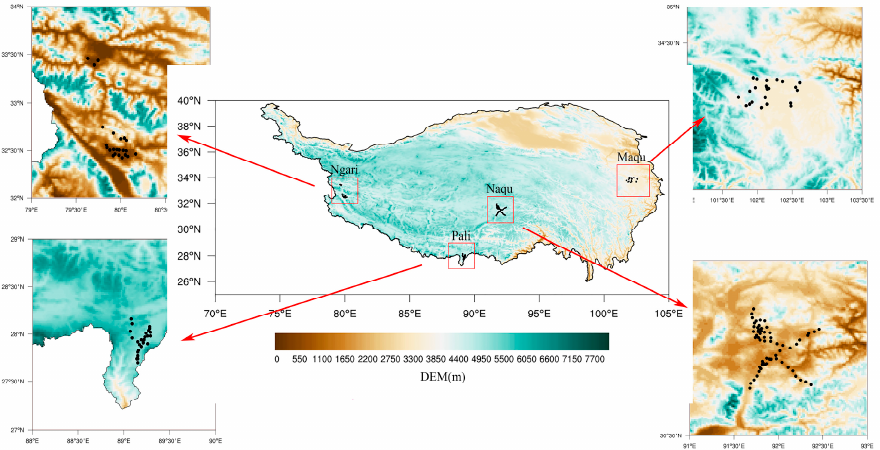
Figure 1. Research area and sites’